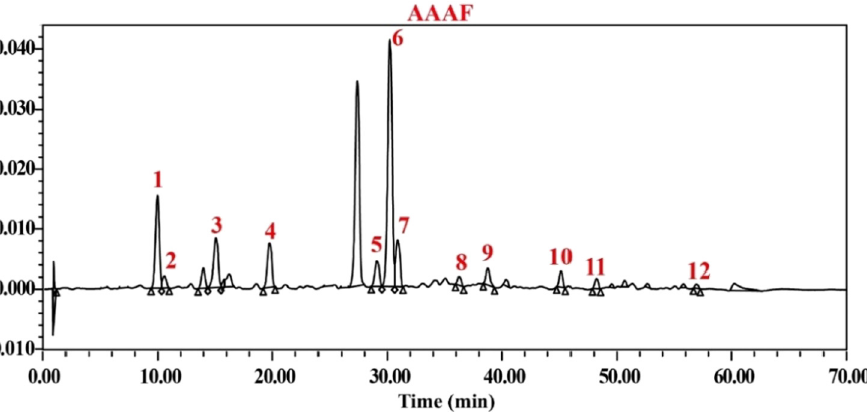
Figure 6: HPLC chromatogram of AAAF. Peaks showing similar retention time to 1: ca ff eic acid ( 9.969 min ) , 2: chlorogenic acid ( 10.569 min ) , 3: epicatechin ( 15.075 min ) , 4: ferulic acid ( 19.765 min ) , 5: hyperoside ( 29.076 min ) , 6: luteolin ( 30.208 min ) , 7: rutin ( 30.891 min ) , 8: apigenin - 7 - o - glucoside ( 36.265 min ) , 9: naringenin ( 38.781 min ) ,10: benzene - triol ( 45.156 min ) , 11: apigenin ( 48.213 min ) and 12: chrysin ( 56.920 min )